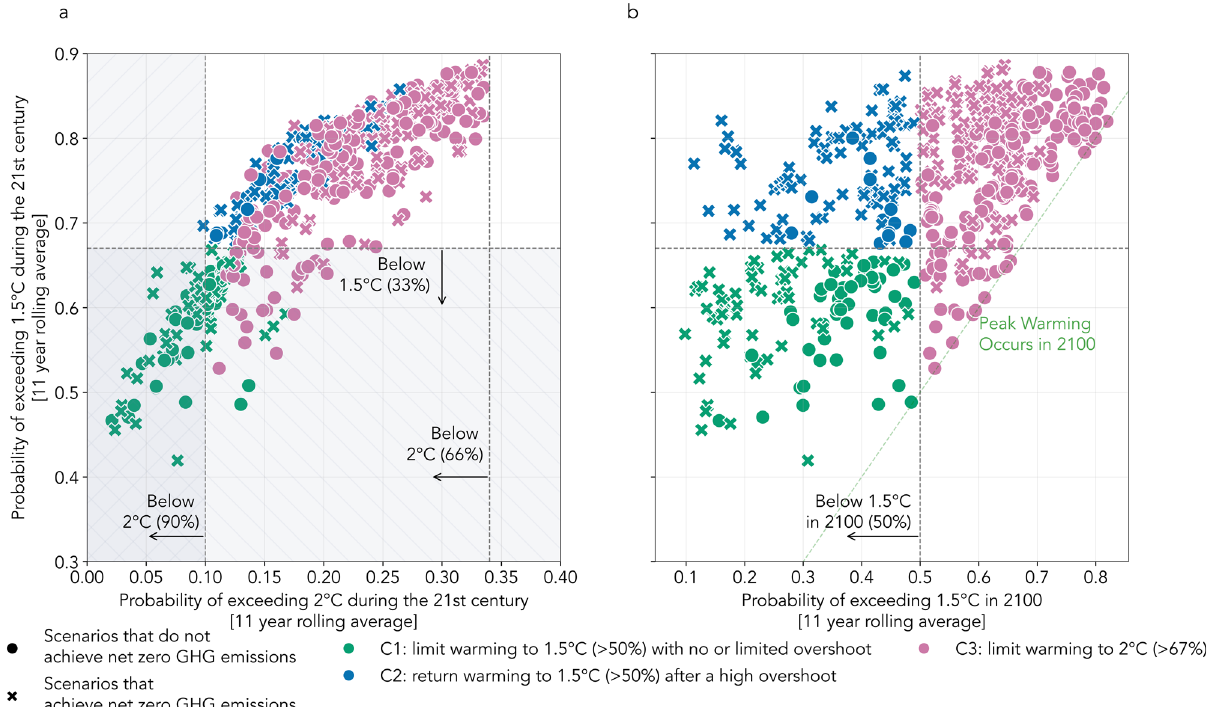
Fig. 1 Probabilities of exceeding 1.5 °C and 2 °C of global warming for different scenario categories. All values presented here use an 11-year running mean applied to the output from MAGICC7 included in the AR6 WGIII database (see Methods). a Probability of exceeding 2 °C against the probability of exceeding 1.5 °C over the 21st century. b Probability of exceeding 1.5 °C in 2100 against the probability of exceeding 1.5 °C at peak warming over the 21st century. The green dashed line indicates pathways for which peak warming occurs in 2100. The scenarios are colored according to their categorization in the AR6 WGIII (compare Table 1). Symbols indicate whether pathways achieve net zero greenhouse gas emissions in the 21 st